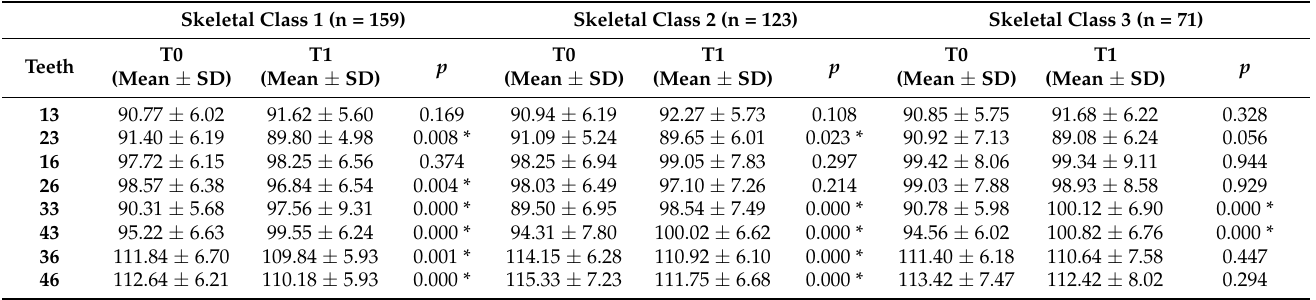
Table 6. Results of T0/T1 angulation changes for skeletal